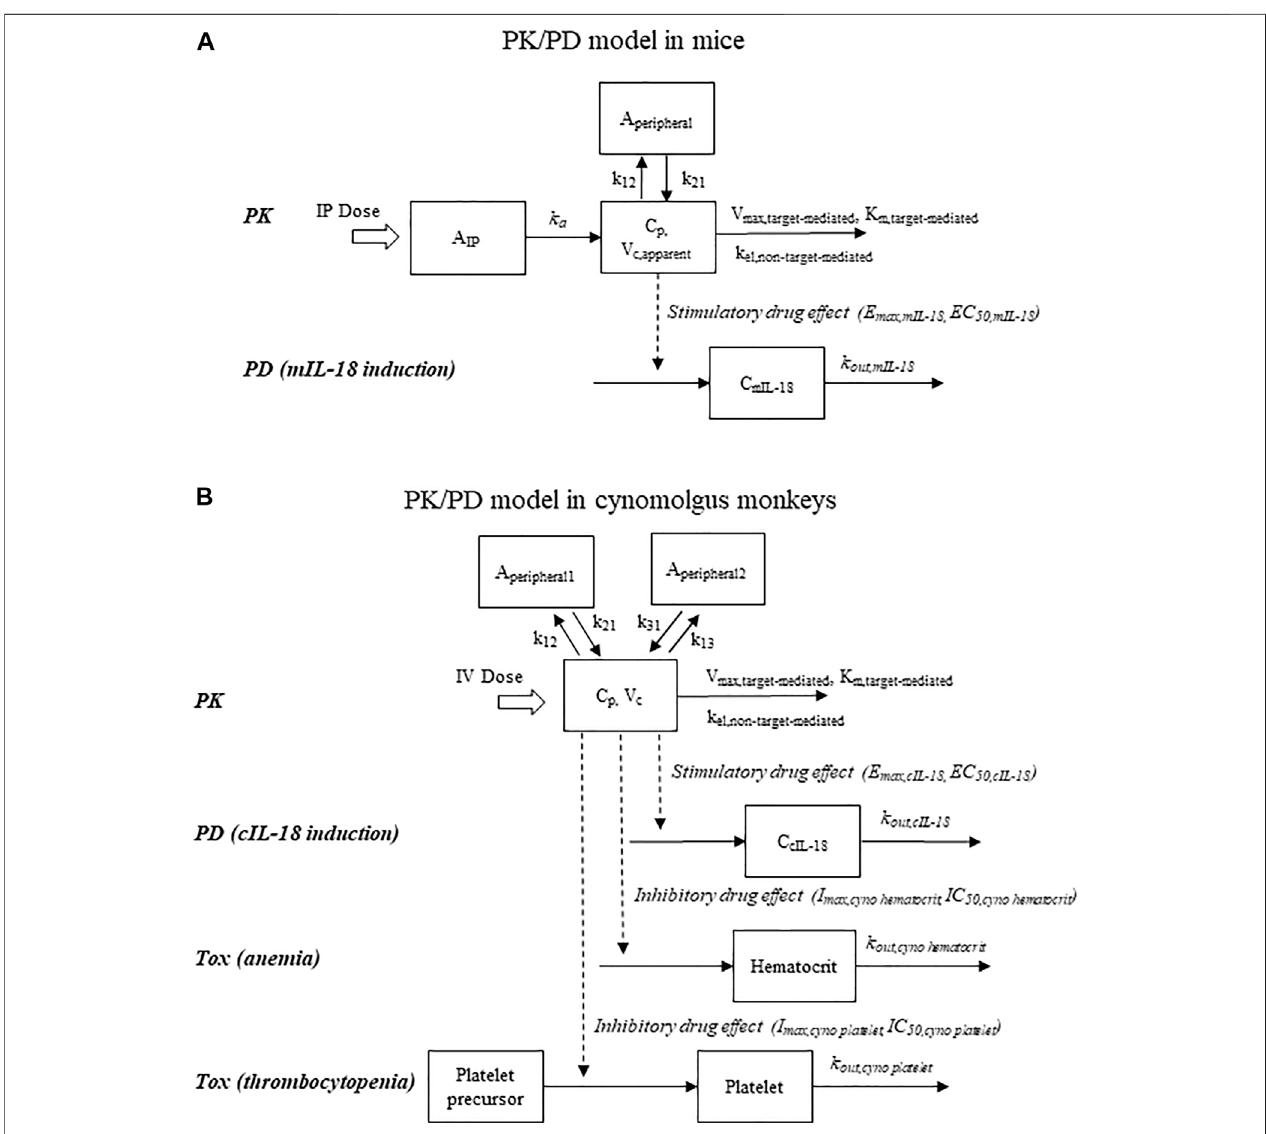
FIGURE 1 | Schematic representations of pharmacokinetic/pharmacodynamic models that describe drug concentrations, pharmacodynamic response (IL-18 induction), and hematological adverse events (reductions in hematocrit and platelet counts). (A) Mouse model; (B) Cynomolgus monkey model. To account for the time delay observed with the IL-18 induction in mice, a time lag in drug administration was incorporated into the mouse model.